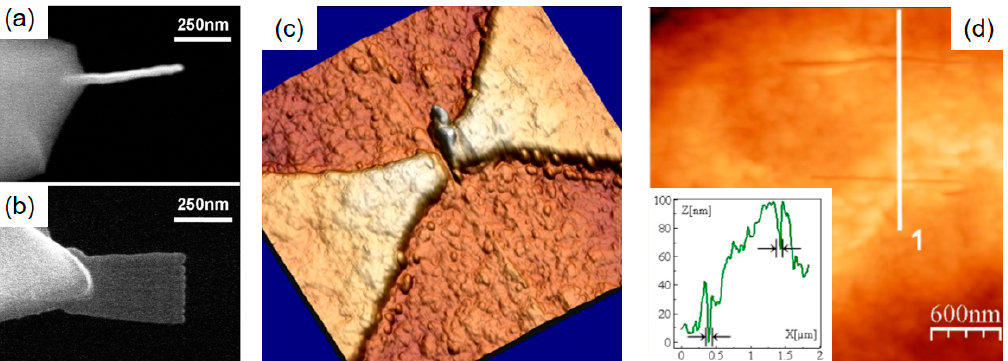
Figure 14. FEBID nano-scalpel. ( a ) and ( b ) are the top and side view SEM images of laterally grown 3D carbon structures, which evolve into blade like structures along the Z axis. Such blades have very sharp end regions with knife-like morphologies, which allow operation as nano-scalpel by modulating the exerted force. ( c ) shows the fabrication of a sub-25 nm wide gap across an Au electrode system by 3D height images, while ( d ) shows an example of a “nano-surgery” in smooth rat aortic muscle cells with constant cut widths of 50 nm, as shown by the cross-section inset at the bottom. Adapted and reprinted from Beard et al., Nanotechnology 2009 [141].